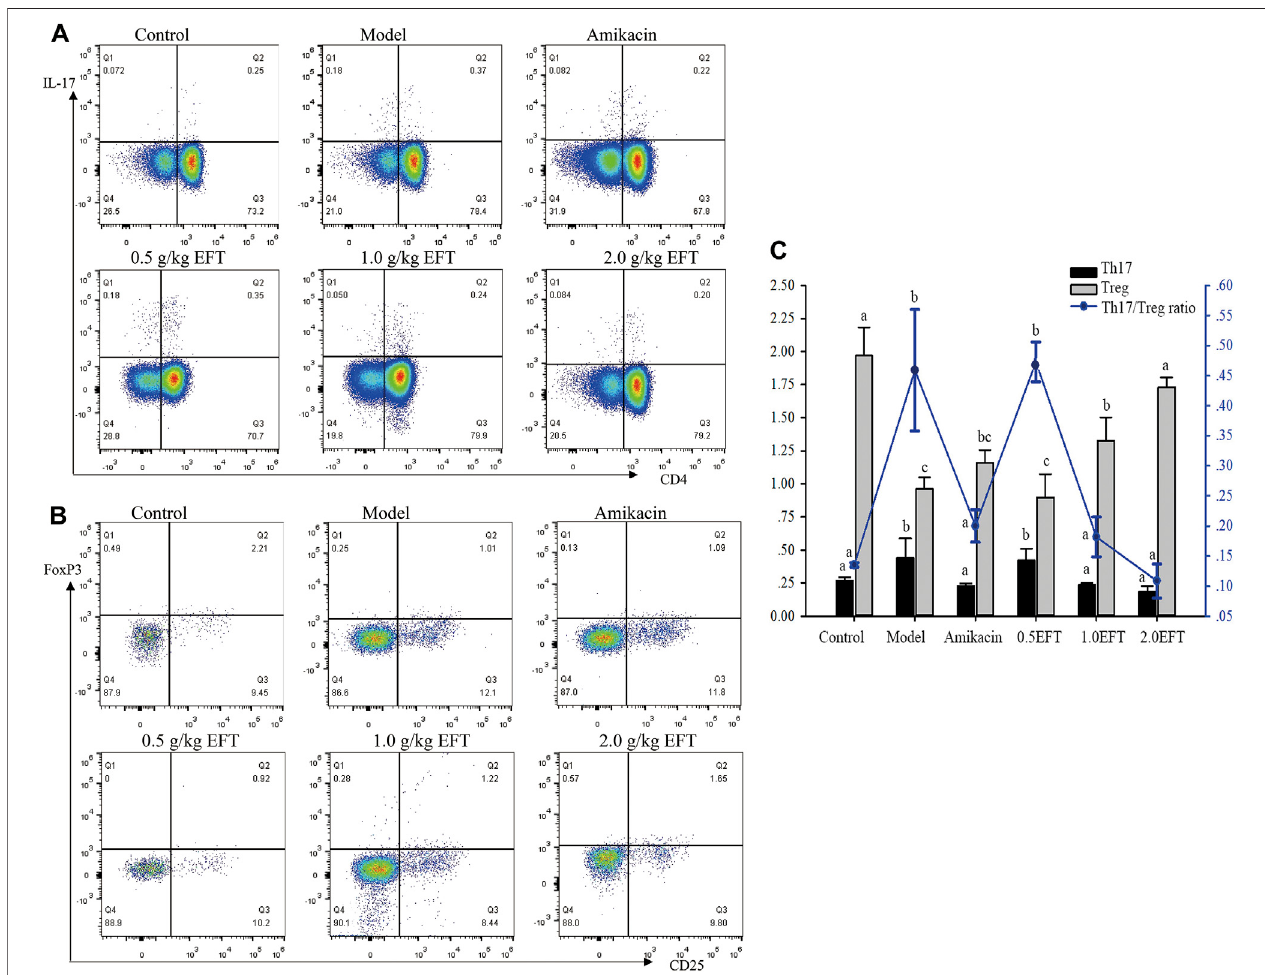
FIGURE7| ThefrequencyTreg(CD4+Foxp3+)cellsandTh17(CD4+IL-17+)cellswereanalyzedbylowcytometry. (A) Representativepicturesforlowcytometryof Treg cells, (B) representative pictures for low cytometry of Th17 cells, and (C) the averages of frequency of Treg and Th17 cells and ratio of Th17/Treg. All values are expressed as mean ± SD ( n (cid:2) 6). Different English letters in the same column represented a signi fi cant difference through pair-wise comparison by the LSD multiple comparison test ( p < 0.05).